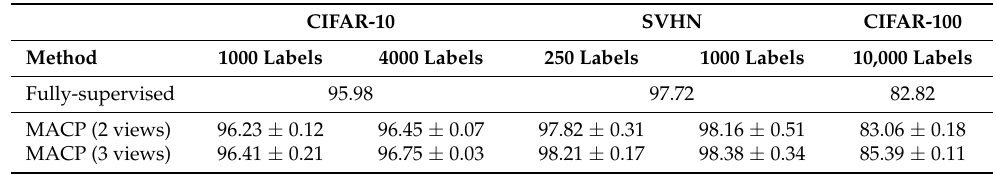
Table 3. Comparison of test accuracy (%) between MACP and fully-supervised method in an ideal multi-view perception environment.